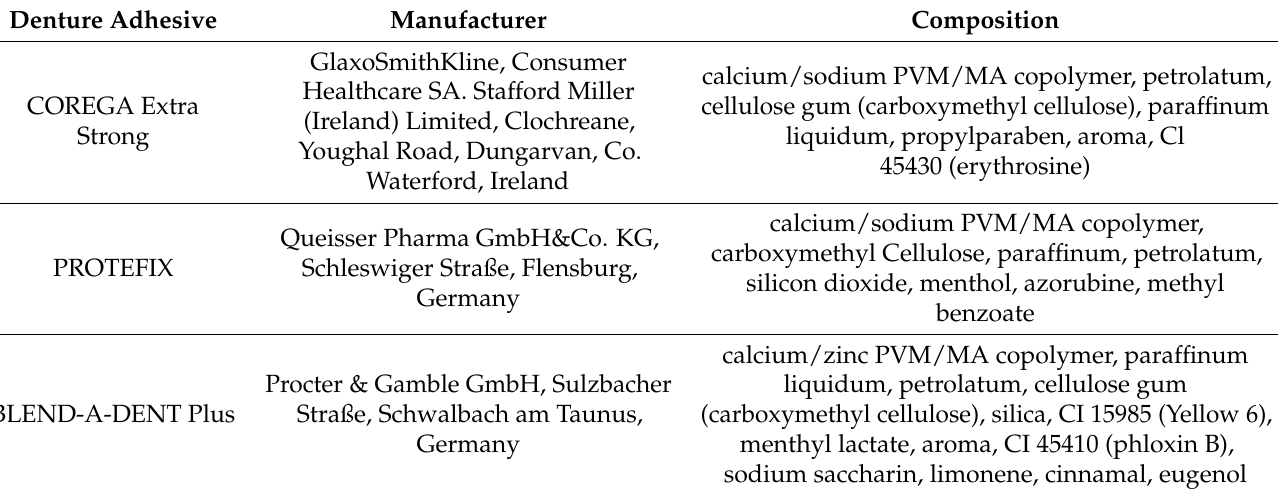
Table 1. Denture adhesives